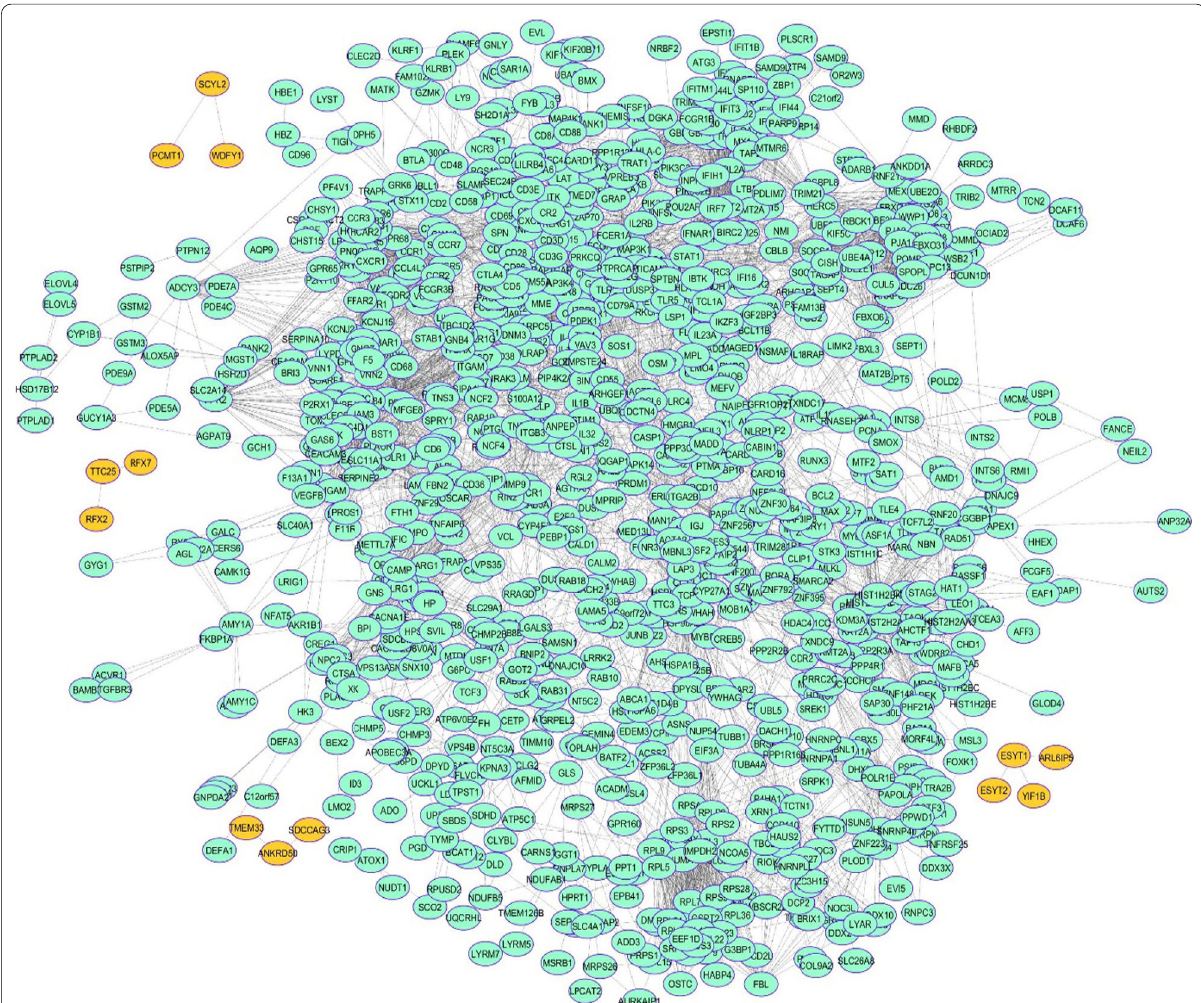
Fig. 2 Overview of the extended network includes one giant network (green) and 4 separate small components (orange) which are derived,